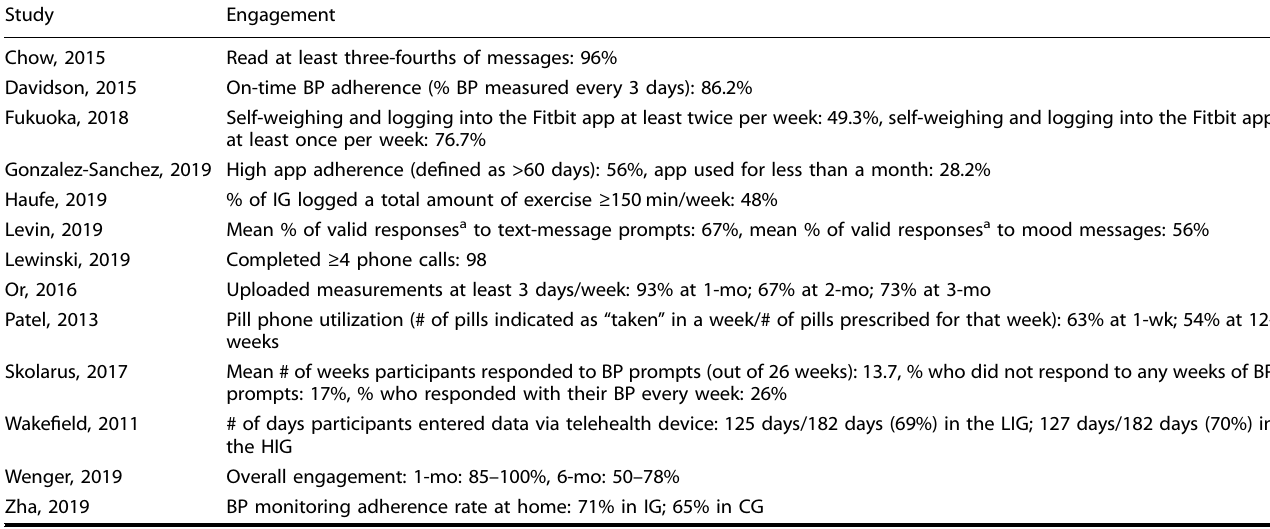
Table 5. Engagement outcomes. Study Engagement